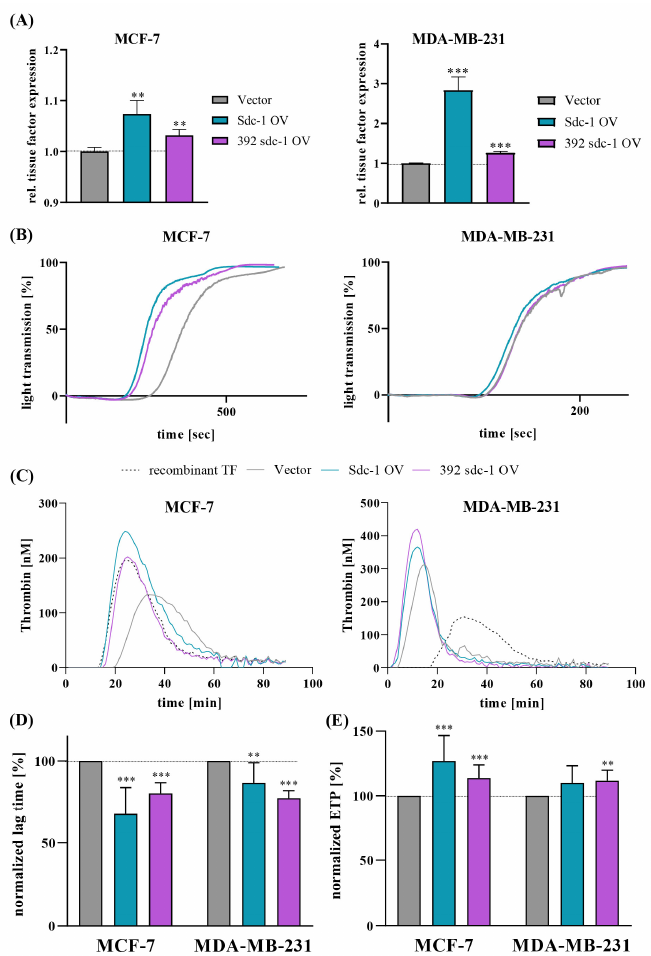
Figure 5. Impact of increased Sdc-1 expression on breast cancer-cell-induced platelet activation and coagulability. In all figure panels, control vector cells are displayed in gray, Sdc-1 OV in cyan, and 392 Sdc-1 OV in violet. ( A ) Flow cytometric detection results of TF expression on breast cancer cells indicated that the upregulation of Sdc-1 was associated with increased TF levels in MCF-7 cells (left diagram) and MDA-MB-231 cells (right). ( B ) Representative curves of light transmission following platelet aggregation indicated that Sdc-1 overexpressing MCF-7 cells (left) and MDA-MB-231 cells (right) tended to induce faster platelet aggregation in comparison to vector controls (n = 4). ( C , D ) Platelet-mediated thrombin generation induced by Sdc-1-overexpressing MCF-7 and MDA-MB-231 cells compared to vector control cells. ( C ) Representative kinetic curves of thrombin formation me- diated by Sdc-1-overexpressing MCF-7 cells (left) and MDA-MB-231 cells (right) displayed a higher endogenous thrombin generation potential (ETP) with respect to increased Sdc-1 levels, confirmed by analyzing the normalized lag time, which was significantly reduced in Sdc-1-overexpressing cells ( D ), whereas ETP was significantly increased (n = 5) ( E ). Panels ( A , D , E ): Data are presented as bar plots and means are represented with lines. Bars with asterisks represent comparisons with statisti- cally significant differences (** p < 0.01, *** p < 0.001).